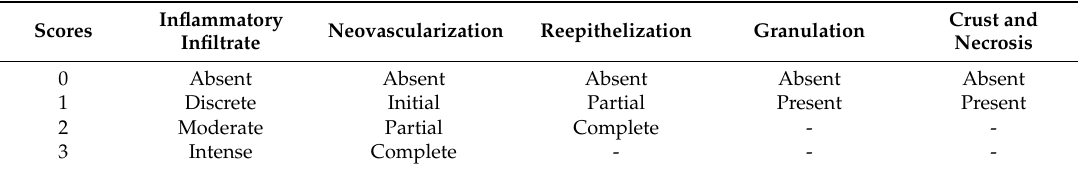
Table 1. Criteria for histological analysis of